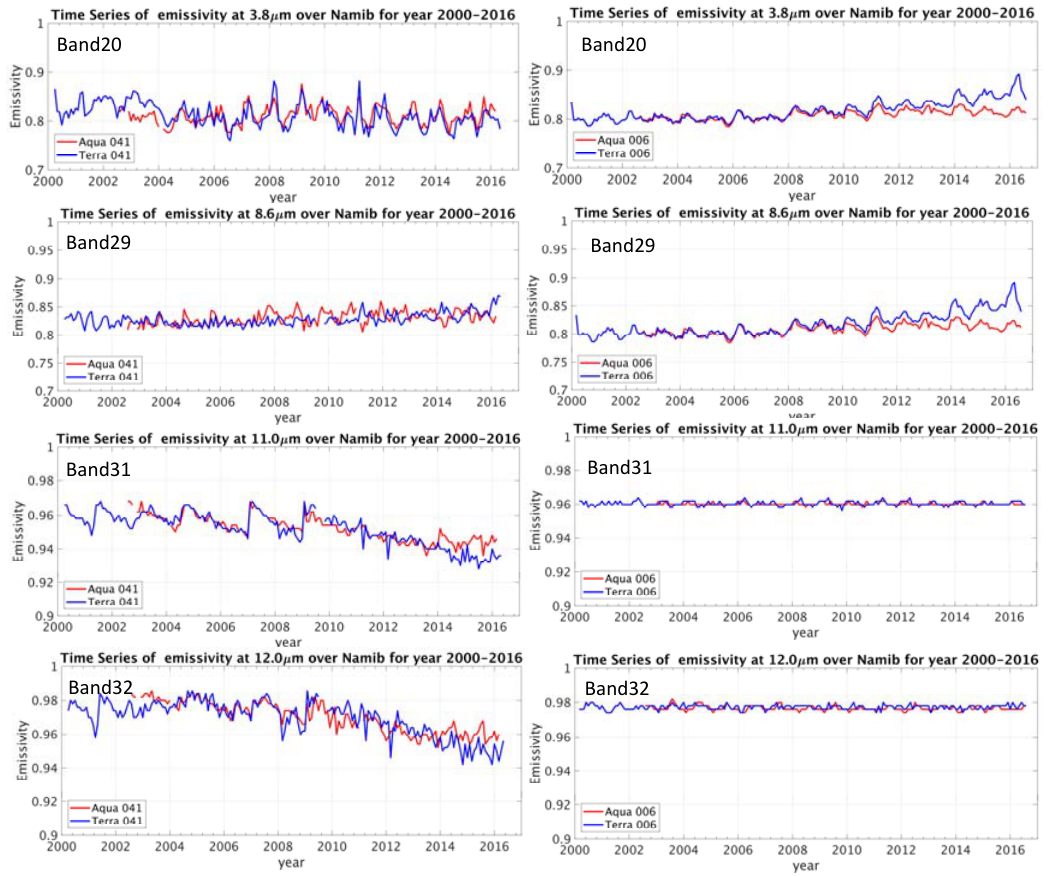
Figure 3. Time series of Col 4/4.1 ( left ) and Col 6 ( right ) band 20, 29, 31, and 32 MxD11C3 monthly mean emissivity for Aqua (red) and Terra (blue) MODIS over a Namib desert location (Lat: 24.25S, Lon:15.25E). Note: In Col 6, band 20 appears to be a copy of band 29 for both Terra and Aqua MODIS.